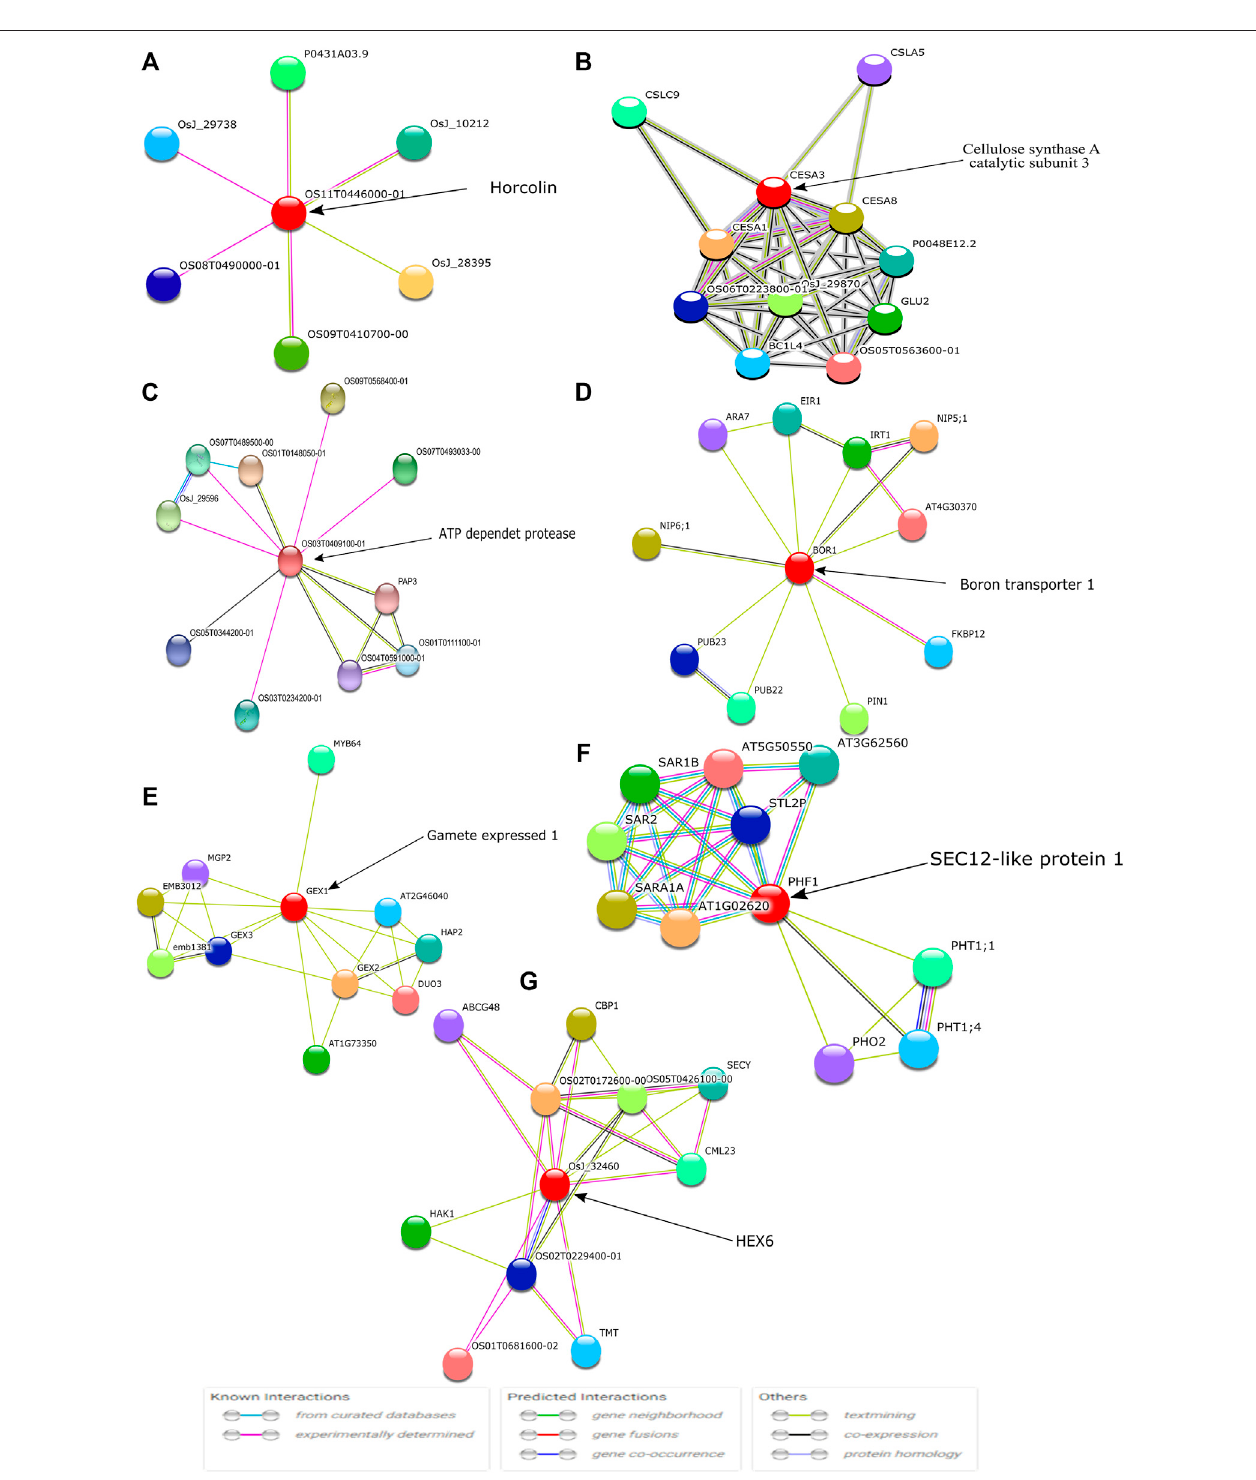
FIGURE 11 | The identi fi ed top hub genes are denoted with circles and are known as the fi rst shell of interactors. Each color symbol signi fi es a speci fi c interaction either known or predicted, as mentioned in previous studies.